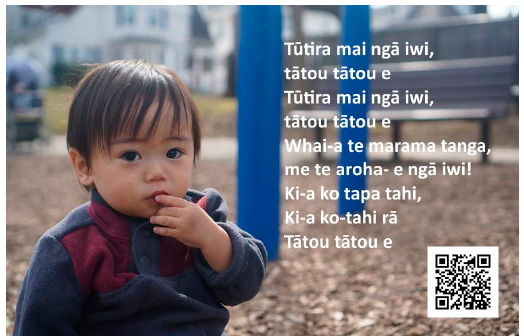
Figure 1. An example of innovative practice co-constructed with the pilot M ā ori early childhood centre (ECC) in response to parents’ need for support to sing along in the M ā ori language with their children at home [44]. The image of the child was retrieved from https://pixabay.com, which is released under the Creative Commons, as is this image CC BY SA3.